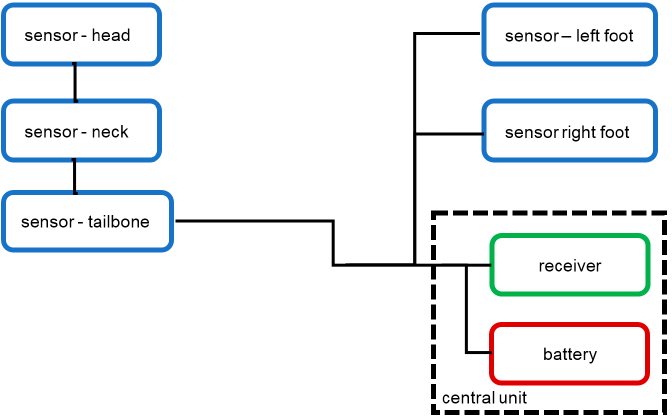
Figure 7. The layout of the measurement system.